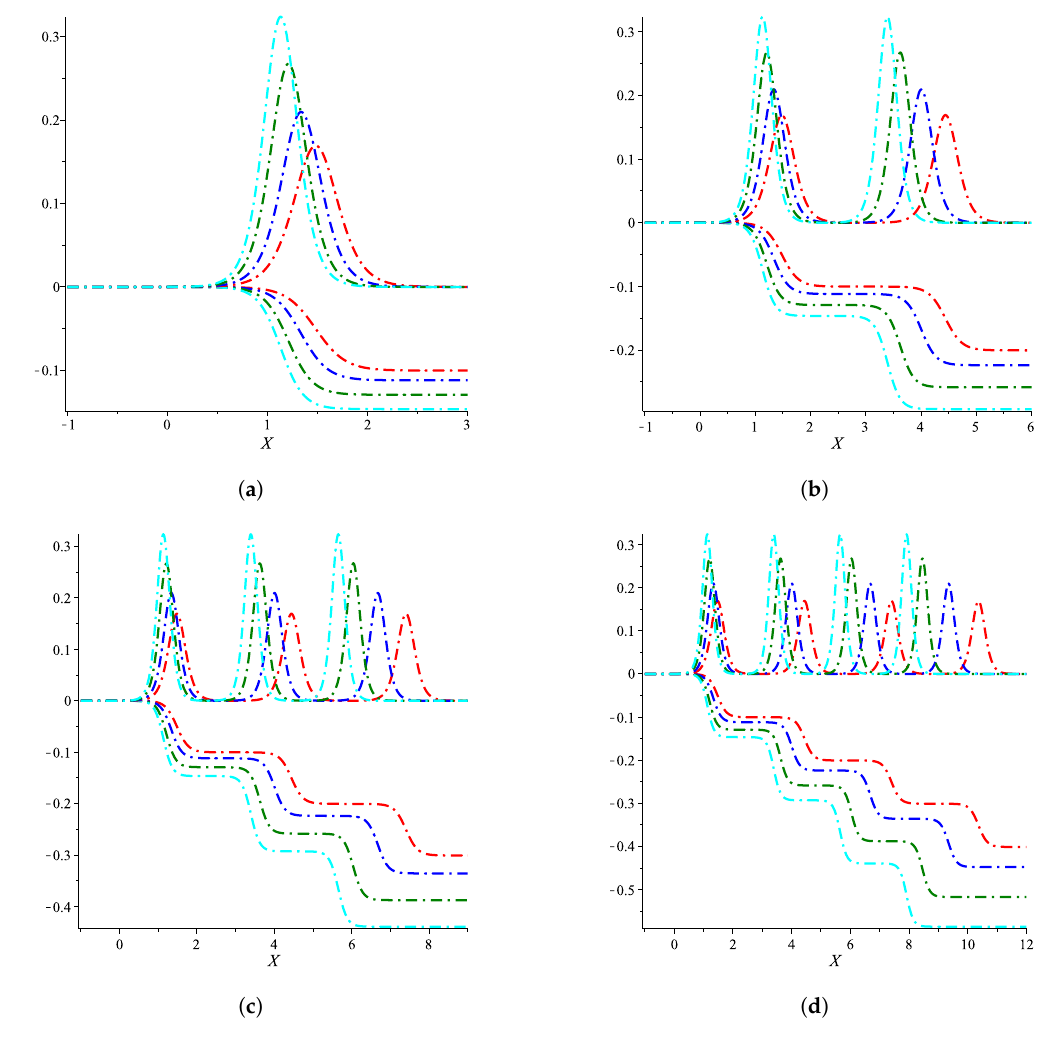
Figure 7. Rarefactive overtaking collision of electrostatic shock wave (lower curves) and its corresponding electric field behavior (upper curves) for ( a ) N = 1, ( b ) N = 2, ( c ) N = 3, and ( d ) N = 4 with α = 0 (red color), 0.1 (blue color), 0.2 (green color), 0.3 (cyan color), M r = 3.75, T ni = 0.05,